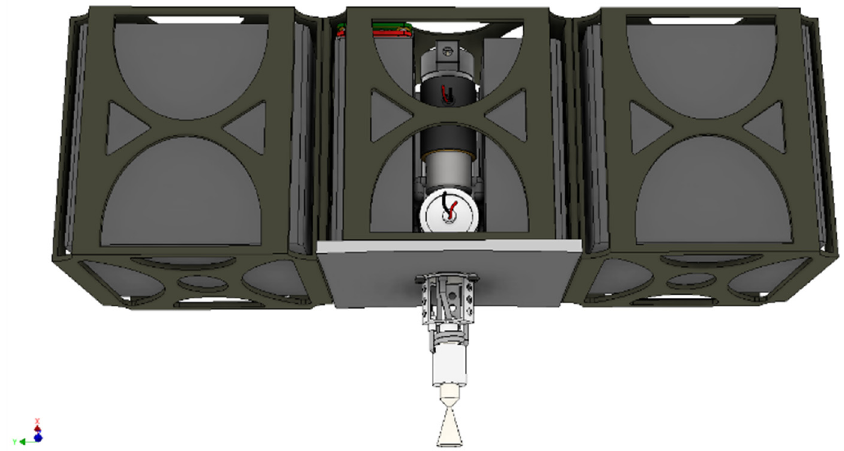
Figure A4. MIMPS-G500mN on a 9U CubeSat with two extension side tanks. I tot ~5000 N s using ASCENT (formerly AF-M315E).